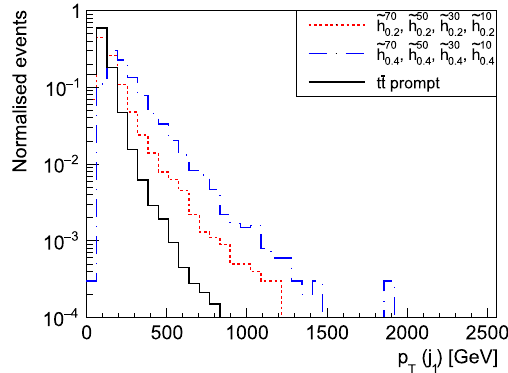
Fig. 22 Transverse momentum of the second leading lepton in the ˜ B - like case